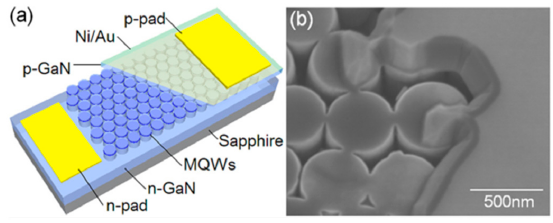
Figure 17. Honeycomb-type VLED with a textured cone-shaped deep-pillar surface